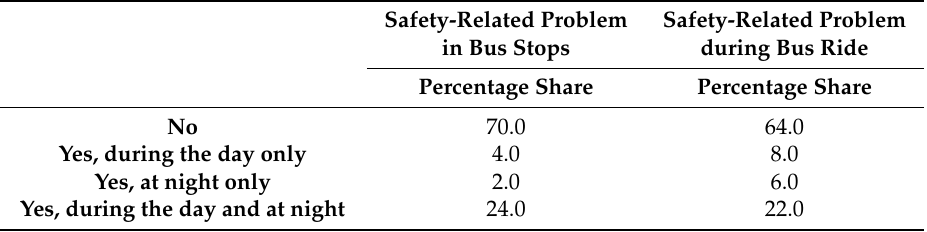
Table 3. Percentage share of respondent’s perception of a safer environment within activity space.